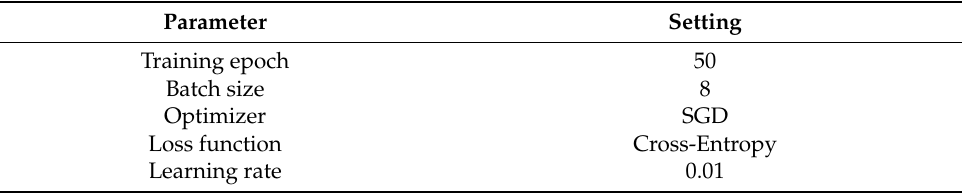
Table 1. Parameters used for the CNNs in this research.